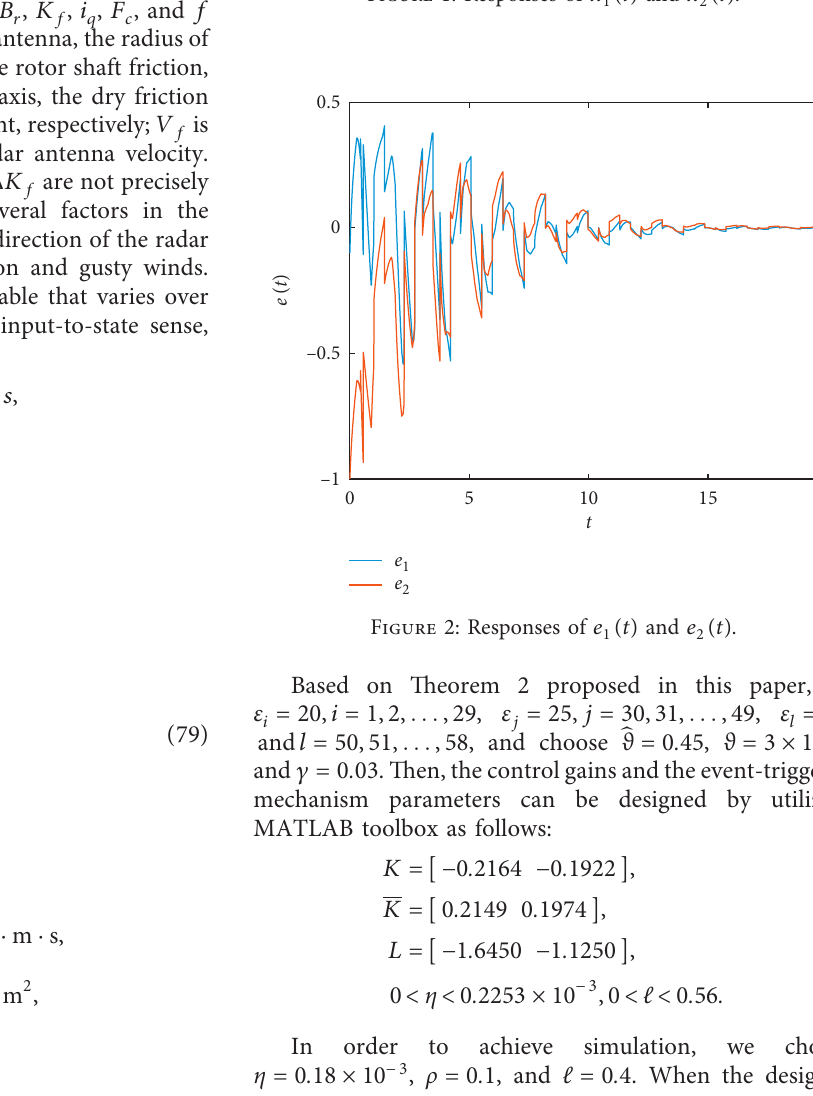
Figure 1: Responses of x